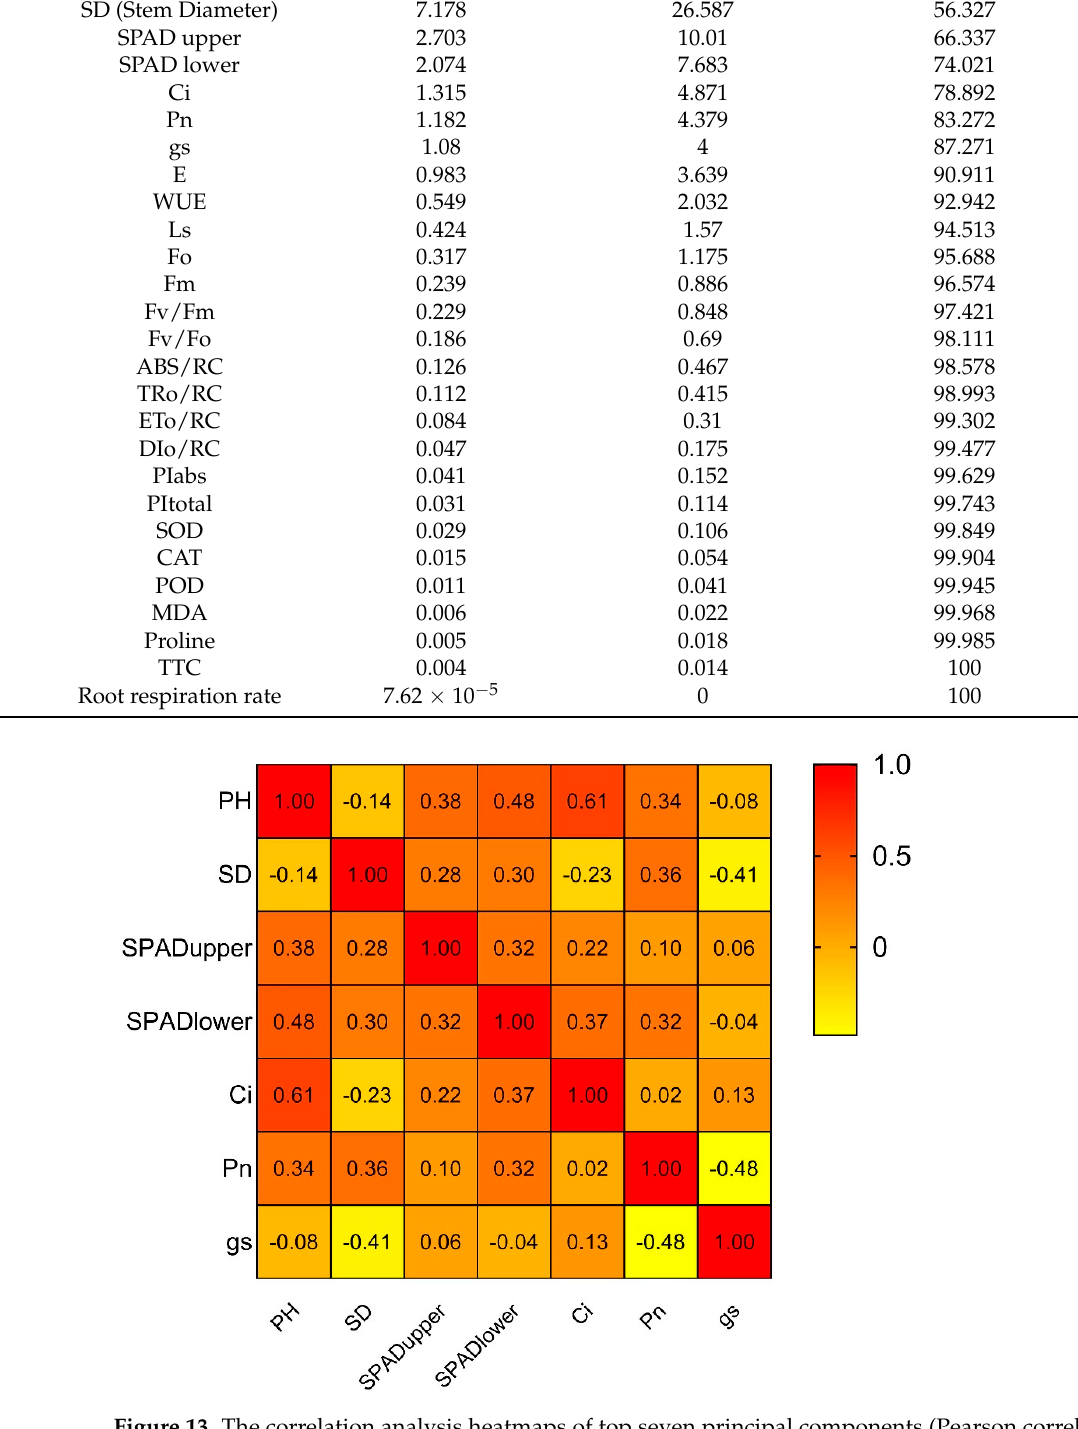
Figure 13. The correlation analysis heatmaps of top seven principal components (Pearson correla- tion coefficients).